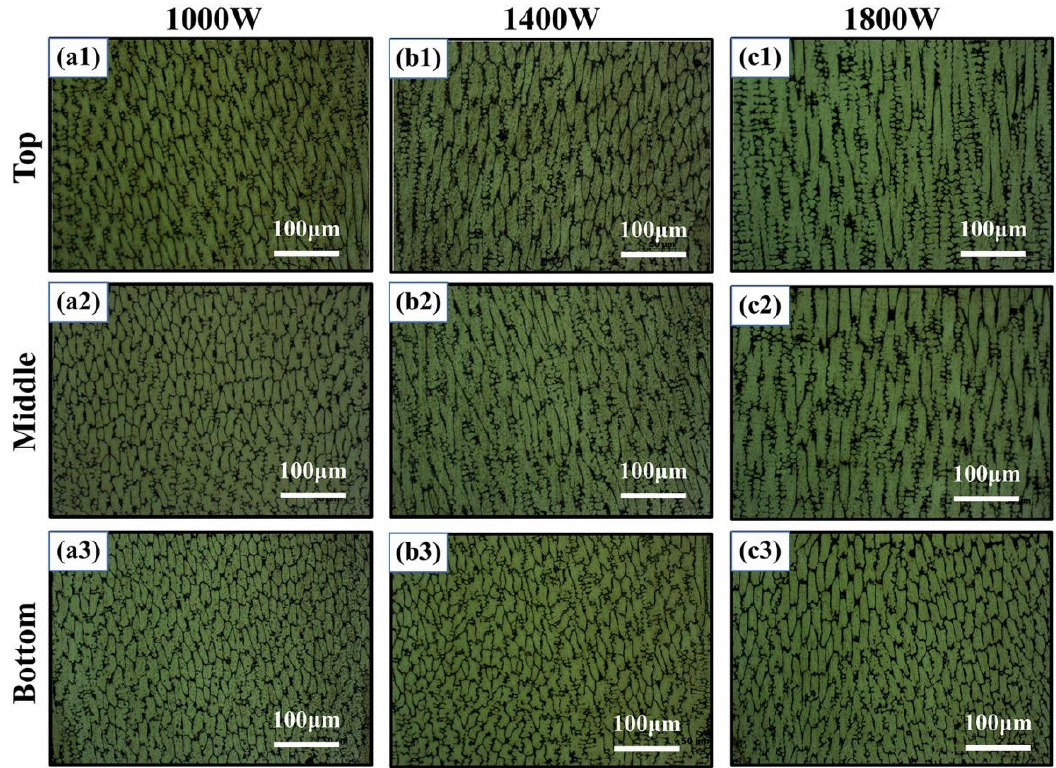
Figure 6. The microstructures of the Al 0.5 FeCoCrNi HEA fabricated by LMD ( a1 – c3 ), where 1, 2, and 3 represent the top, middle, and bottom locations of the sample, respectively.